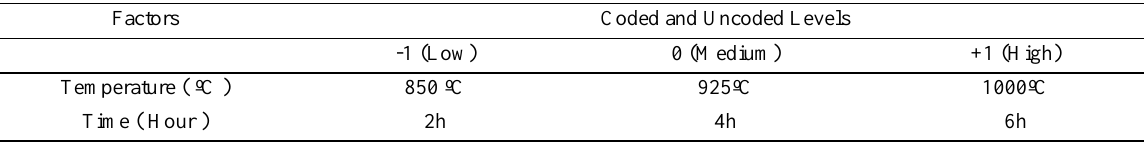
Table 1. Coded and uncoded level of factors.